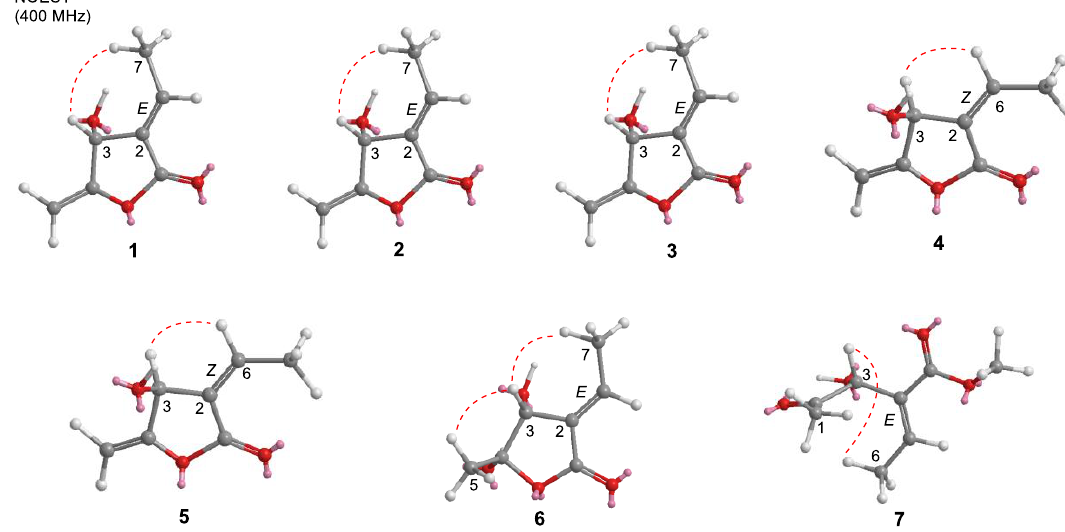
Figure 3. Key NOESY (red dashed lines) correlations for compounds 1 – 7.